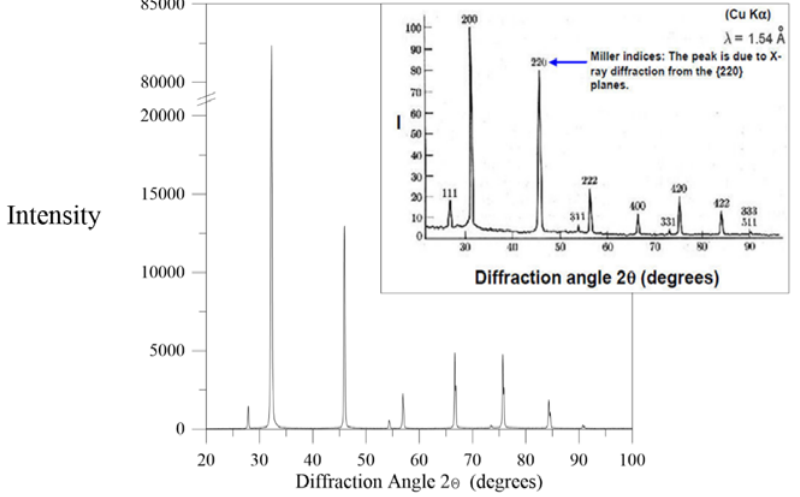
Figure 7. XRD spectra obtained from the recovered crystals from produced water. Spectra of NaCl from literature has been shown in inset.